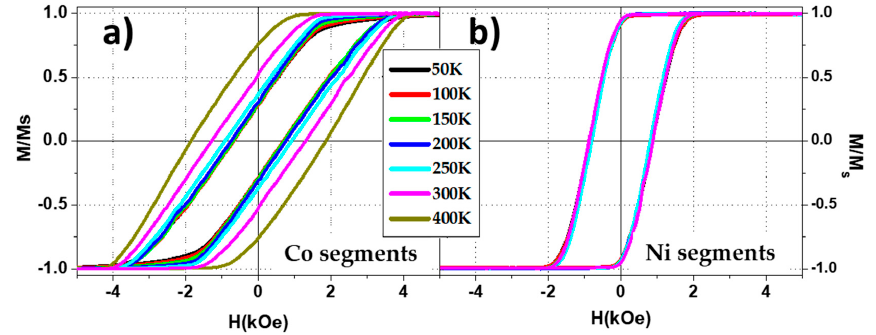
Figure 7. Parallel hysteresis loops measured at different temperatures ranging from 50 K to 400 K for Co ( a ) and Ni ( b ) nanowire arrays.